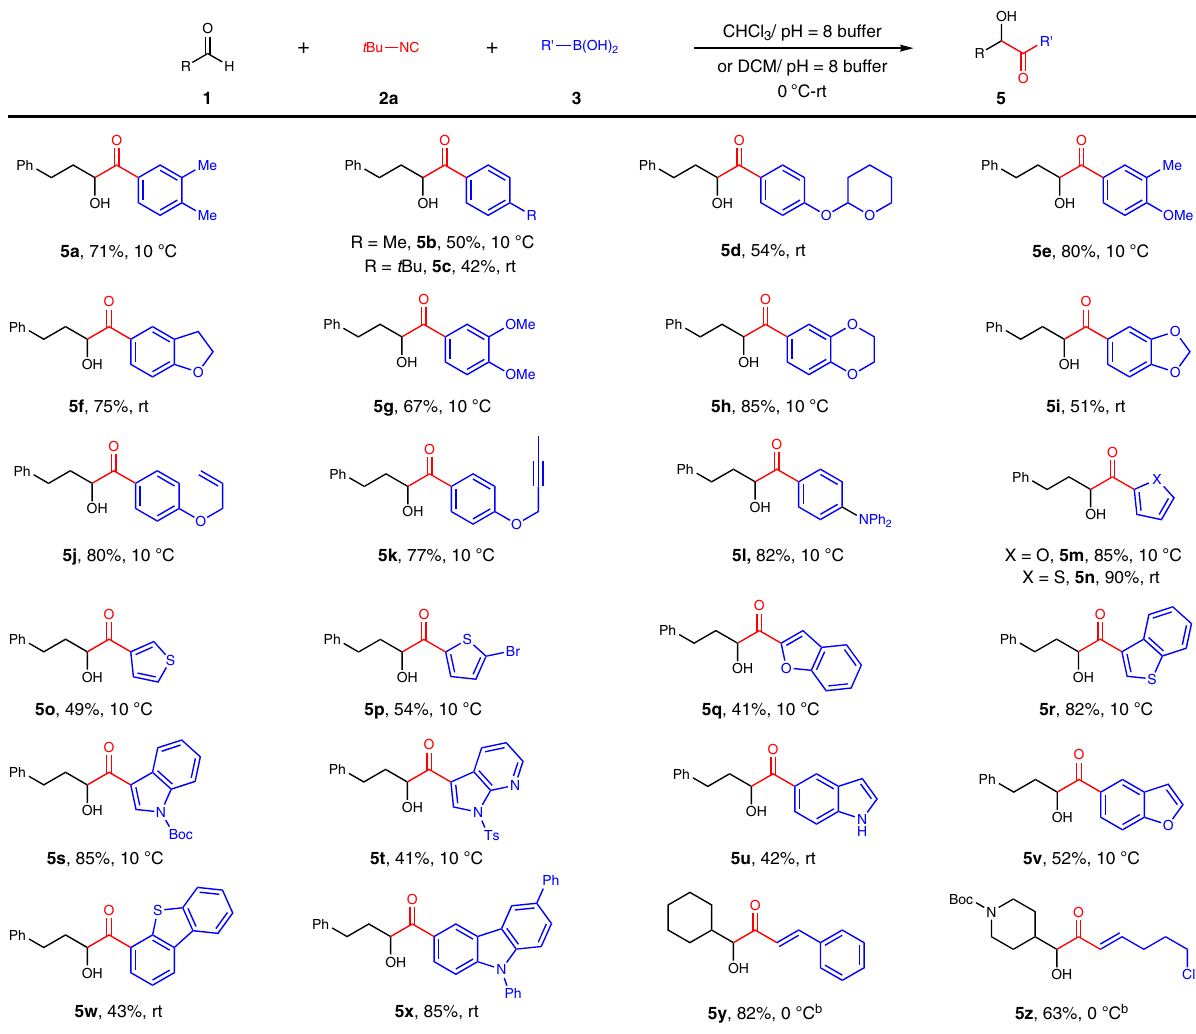
Fig. 3 Scope of boronic acids a . Reaction conditions: a 1a (0.2 mmol, 1 equiv), 2a (0.3 mmol), 3 (0.36 mmol), and CHCl 3 /pH = 8 buffer (7:3, 1 mL) under an argon atmosphere for 24 hours unless otherwise speci fi ed. b 1 (0.2 mmol, 1 equiv), 2a (0.3 mmol), 3 (0.36 mmol), and DCM/pH = 8 buffer (7:3, 1 mL) under an argon atmosphere for 24 hours.